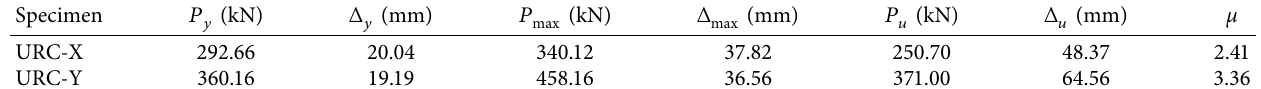
Table 5: Summary of comparison analysis results.